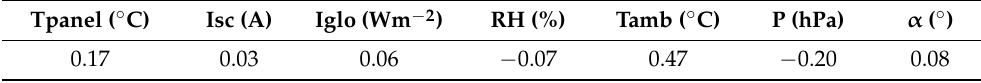
Table 2. Correlation coefficient of variables against instantaneous soiling